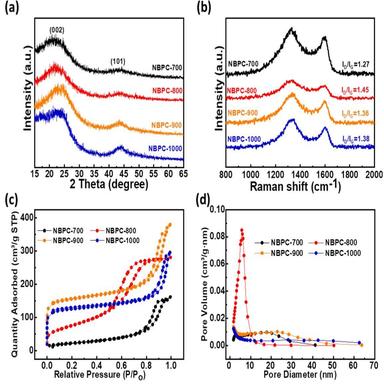
(a) XRD patterns and (b) Raman spectra, (c) Nitrogen adsorption/desorption isotherms, and (d) the corresponding pore-size distributions of NBPC-700, NBPC-800, NBPC-900, and NBPC-1000.